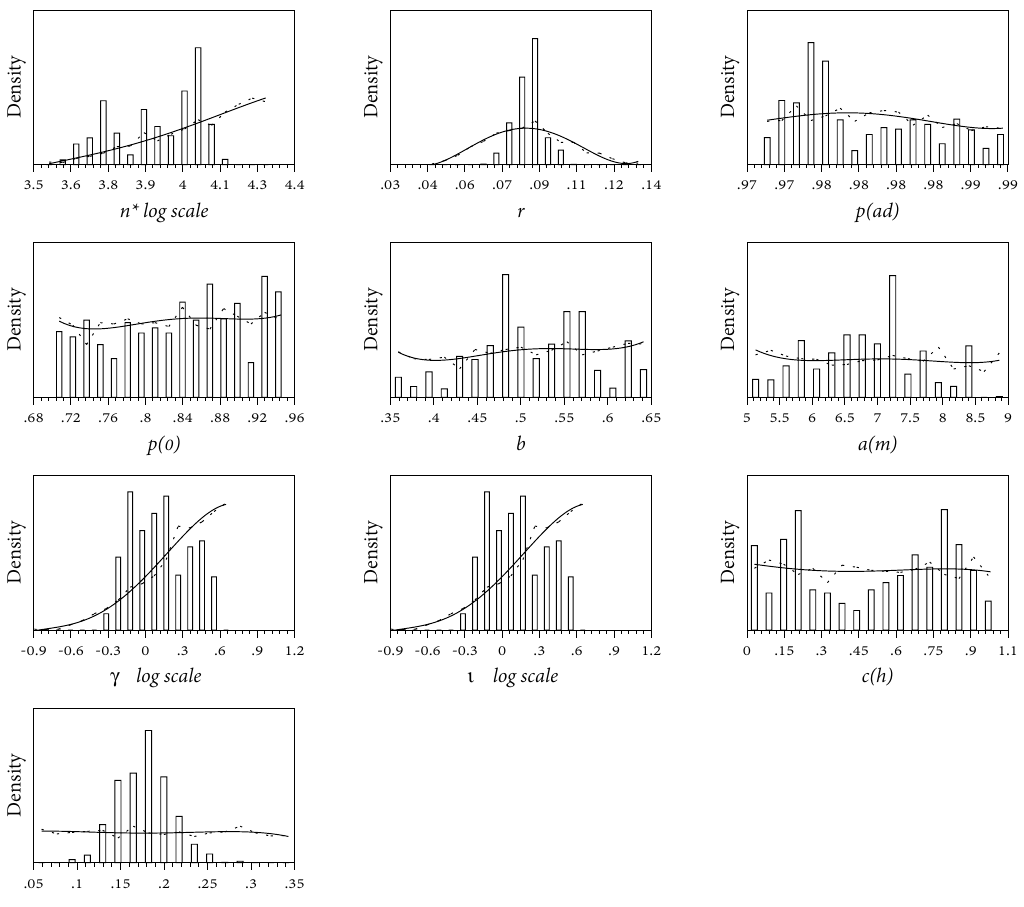
Fig. 6. Realised prior (dashed curve; solid curve fitted polynomial) and posterior (bars) parameter distributions for selection-delayed dynamics in Baffin Bay walruses (model sB). For parameter symbols see Table